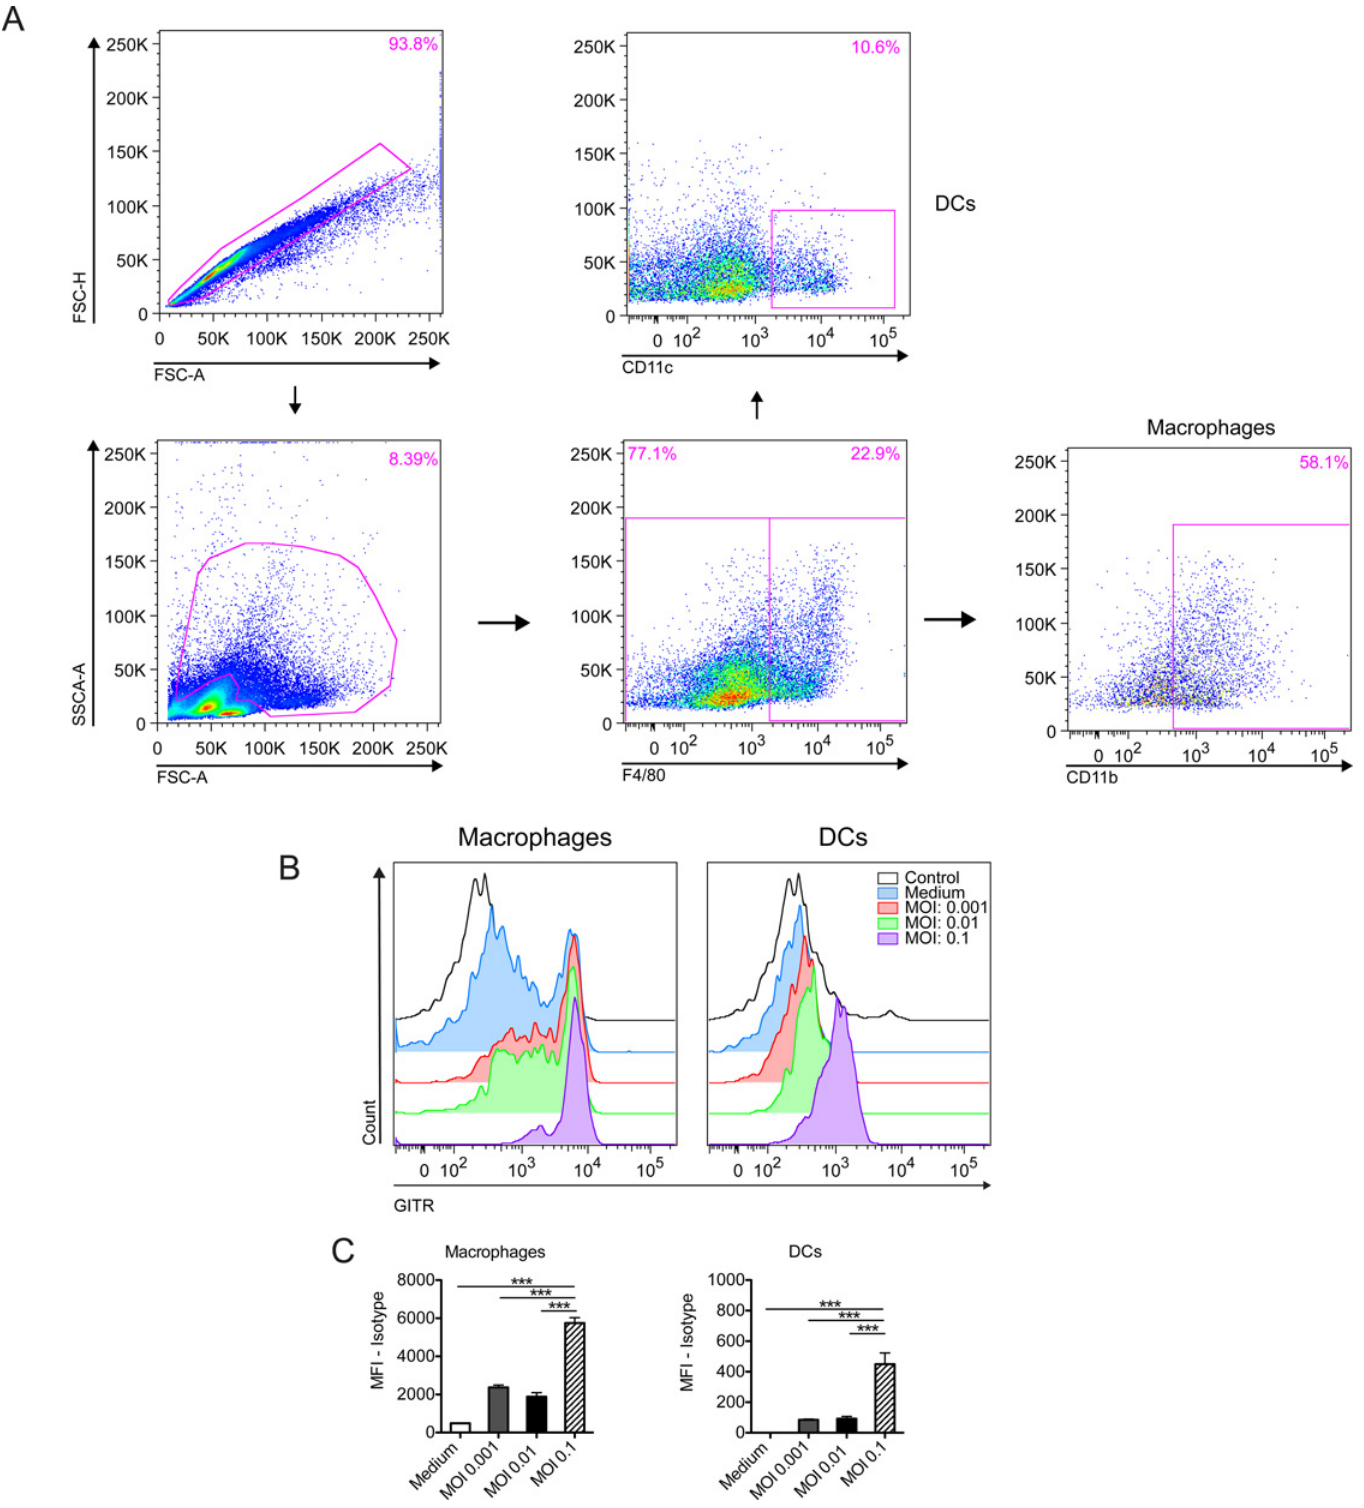
Fig 2. GITR expression in the myeloid compartment. Splenocytes from na ï ve C57BL/6 mice were collected, stimulated or not with tachyzoites of the ME- 49 strain at different MOIs (MOI: 0.1; 0.01 and 0.001) and kept in culture for 24 hours. GITR expression was then analyzed by flow cytometry. Gating strategy is depicted in (A), histogram plots in (B) and MFI expression in (C). The myeloid cells were first identified and gated based on their FSC and SSC profile after doublets exclusion. Macrophages were considered as F4/80 + CD11b + and dendritic cells as F4/80 - CD11c + gated on the myeloid cell region. Error bars indicate mean ± SEM. *** P < 0.001. The experiment was performed twice with six technical replicates in each experiment. doi:10.1371/journal.pone.0152622.g002 PLOS ONE | DOI:10.1371/journal.pone.0152622 March 30,